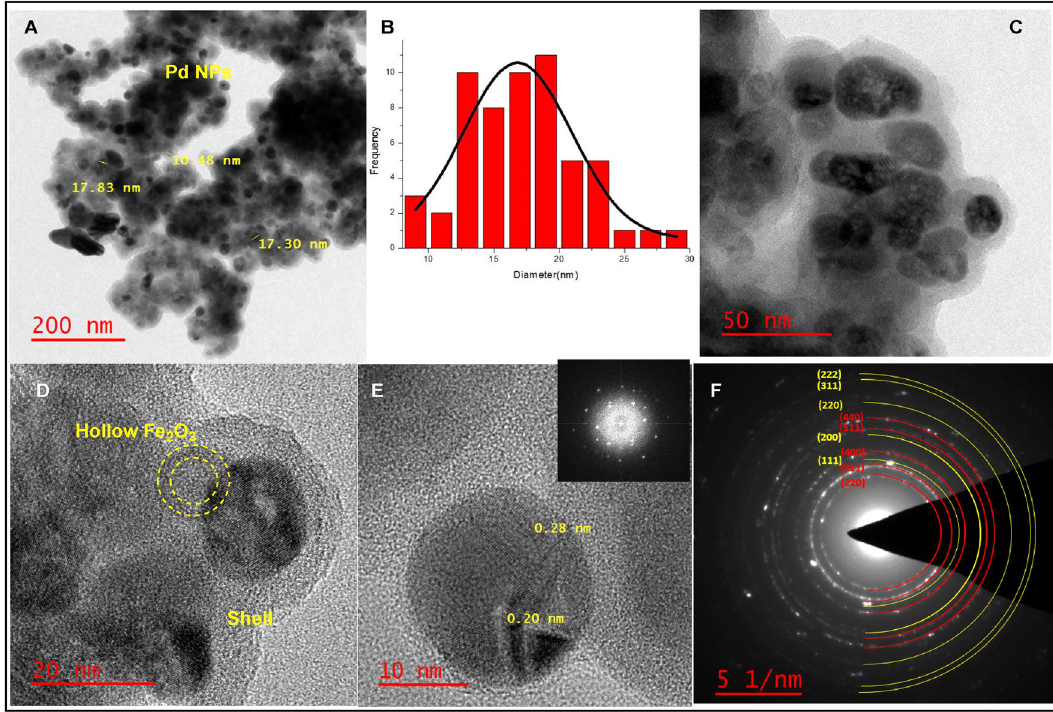
Figure 1. (A,C) TEM images of Pd@h-Fe 2 O 3 @C, (B) size distribution histogram of Pd NPs, (D,E) HRTEM images of Pd NPs and (F) SAED pattern of Pd@h-Fe 2 O 3